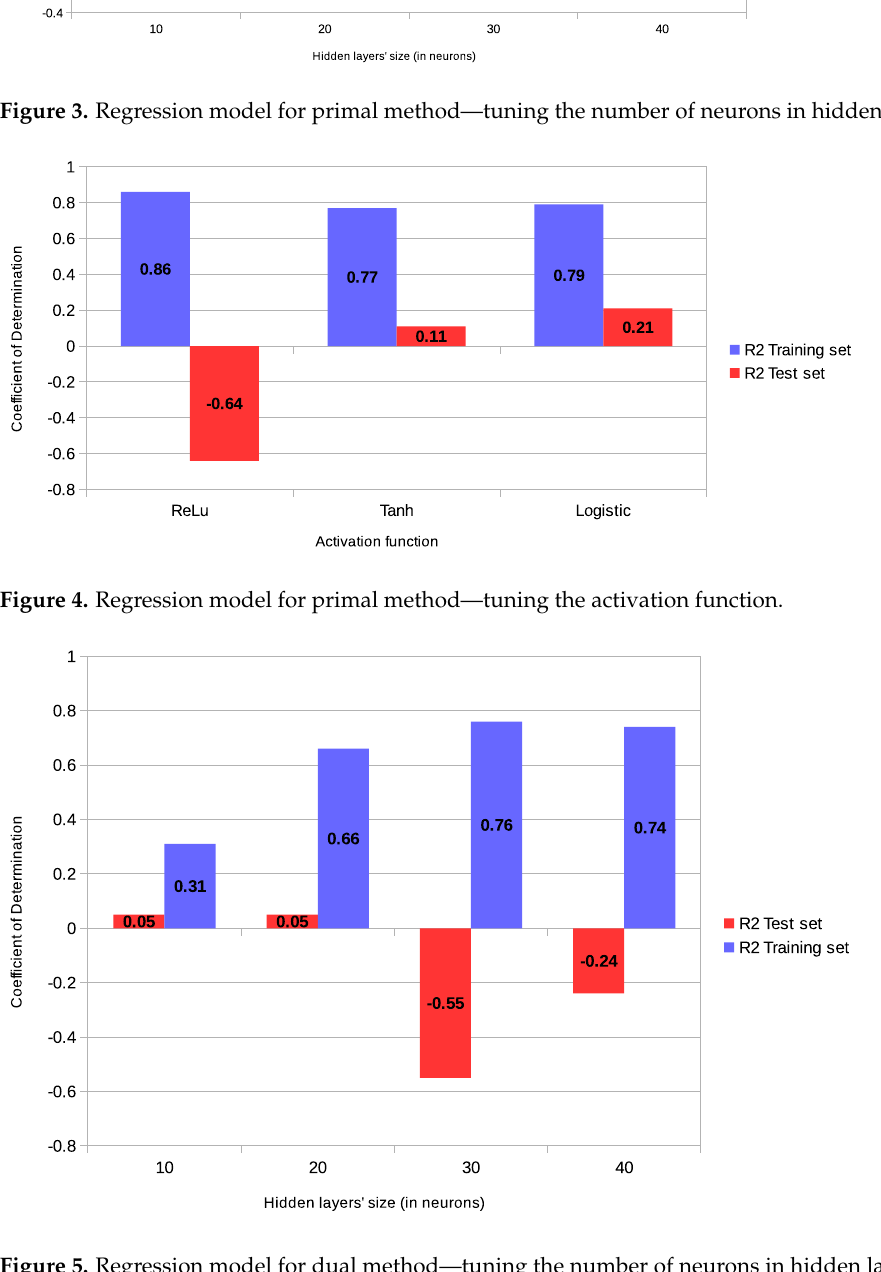
Figure 5. Regression model for dual method—tuning the number of neurons in hidden